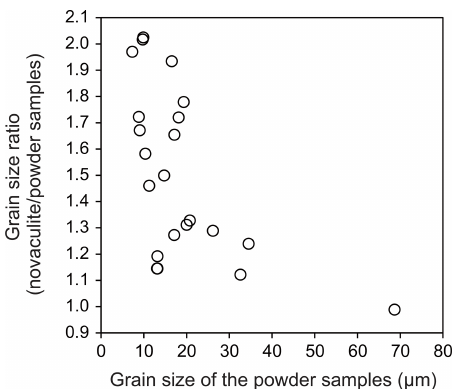
Figure 6. Grain size ratios between the novaculite and quartz pow- der samples. The ratios decrease with increasing grain size for both types of quartz sample. This is related to the closing of pores in the quartz powder